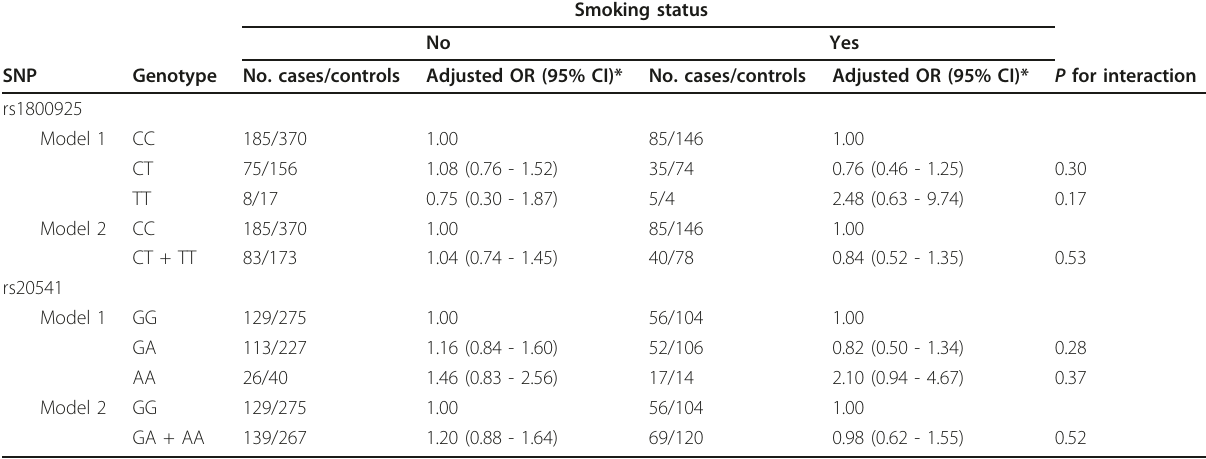
Table 5 Association between IL13 polymorphisms and rhinoconjunctivitis, stratified by smoking status in Japanese women, KOMCHS,